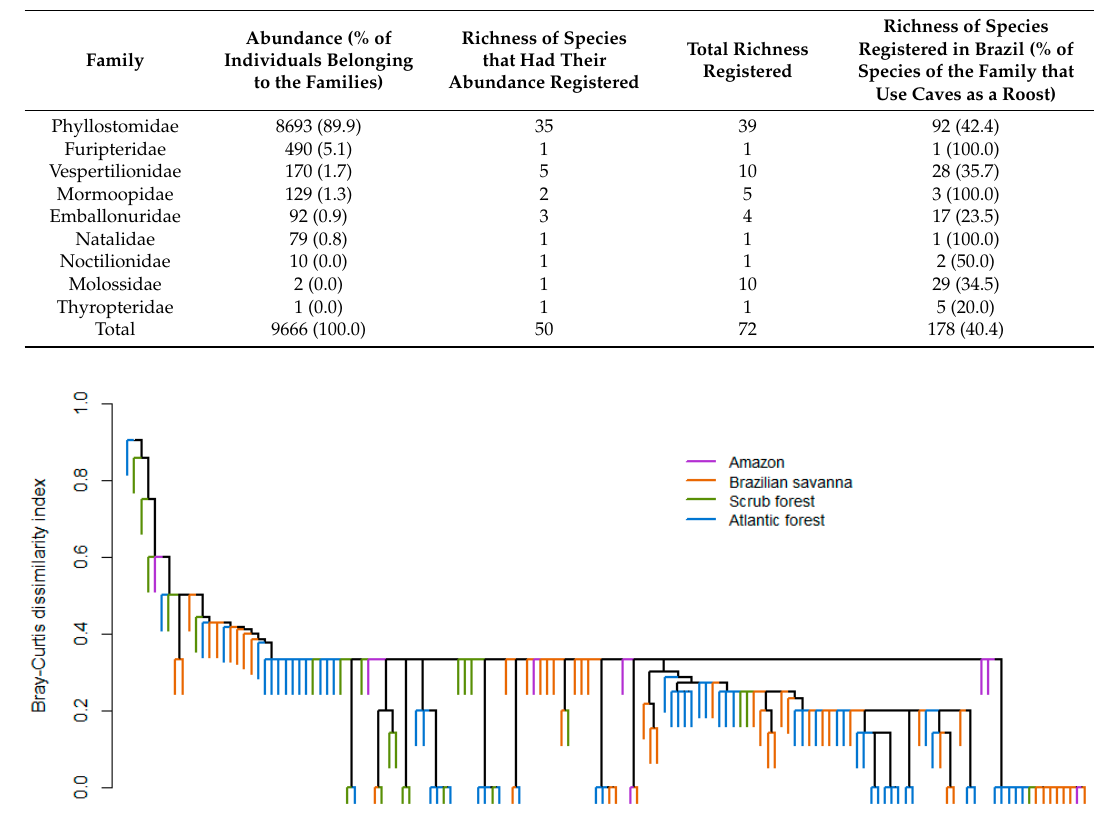
Table 1. Species richness and ranking of abundance of families of Brazilian cave bats.